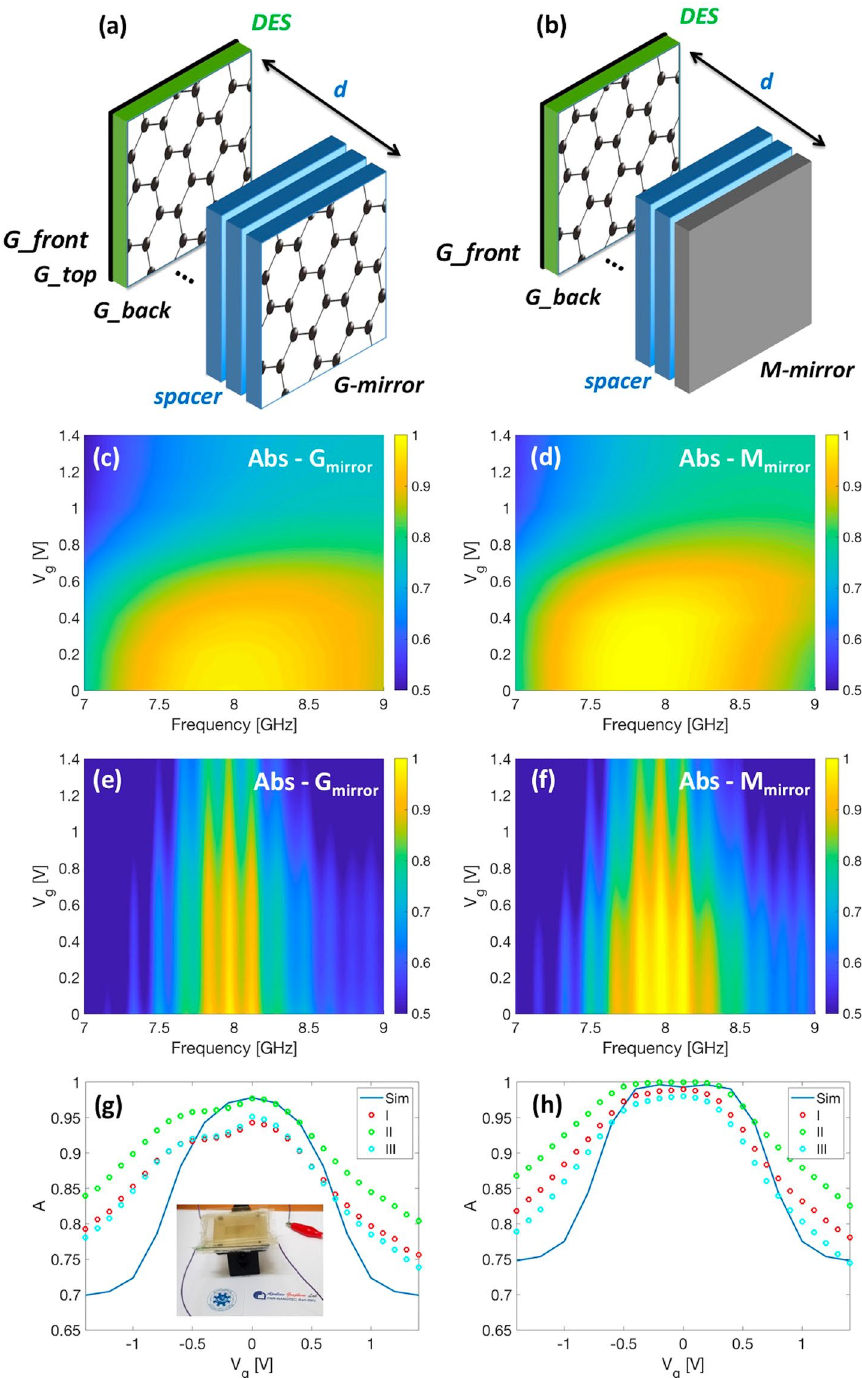
Figure 5. Sketch of the Salisbury screen realized by sandwiching the glass spacer between the electrochemical capacitor and the ( a ) graphene-based and ( b ) metallic mirrors, respectively. In both configurations the spacer thickness d is equal to 3.8 mm in analogy to what has been done in ref. 13 . ( c , d ) Theoretical and ( e , f ) experimental absorption maps for ( c – e ) G-mirror and ( d – f ) M-mirror. ( g , h ) Absorption versus gate voltage V g for three maxima (I - first at 7.84 GHz, II - second at 7.97 GHz and III -third at 8.11 GHz). The blue line corresponds to the numerical absorption at 7.97 GHz. Inset ( g ) picture of the transparent absorber based on the Salisbury screen